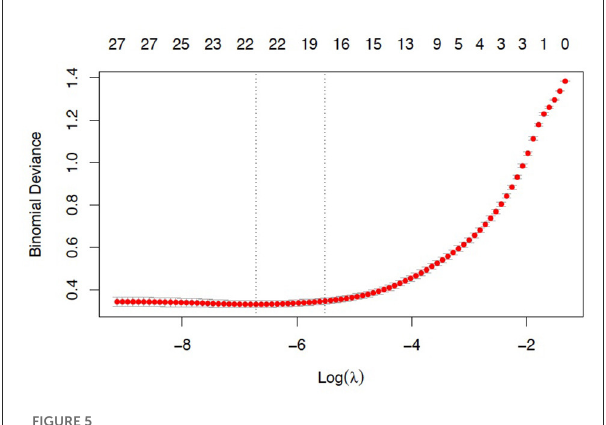
FIGURE5 LASSO regression model for voice quality features by race rating.